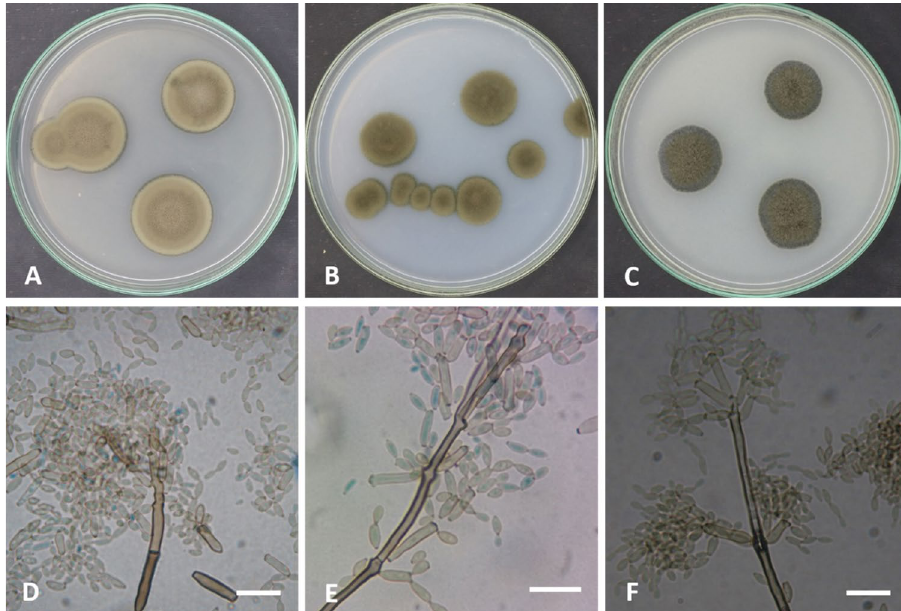
Figure 6. Cladosporium compactisporum (AUMC 11366). ( A–C ) 7-day-old colonies on PDA, SNA and OA at 25 °C. ( D–F ) Geniculate and swollen conidiophore bearing compact chains of conidia. Scale bar = 20 µm.